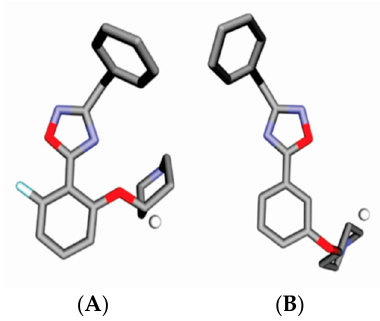
Figure 7. Representation of GCOD-5 (0,3, − 3, any) (white sphere) and ( A ) compound 79 , and ( B ) compound 30 . CODs occupancy represented by white spheres contributes to increasing the potency of compounds, and the gray and red representations are carbons and oxygen atoms.